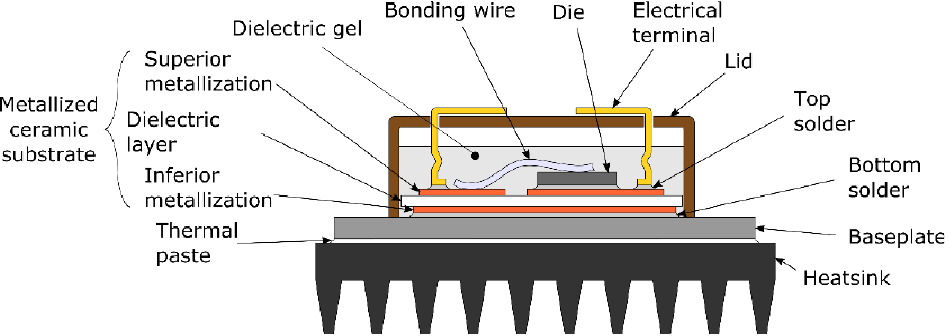
Figure 2. Internal structure of a generic IGBT/MOSFET power module as shown in [16].